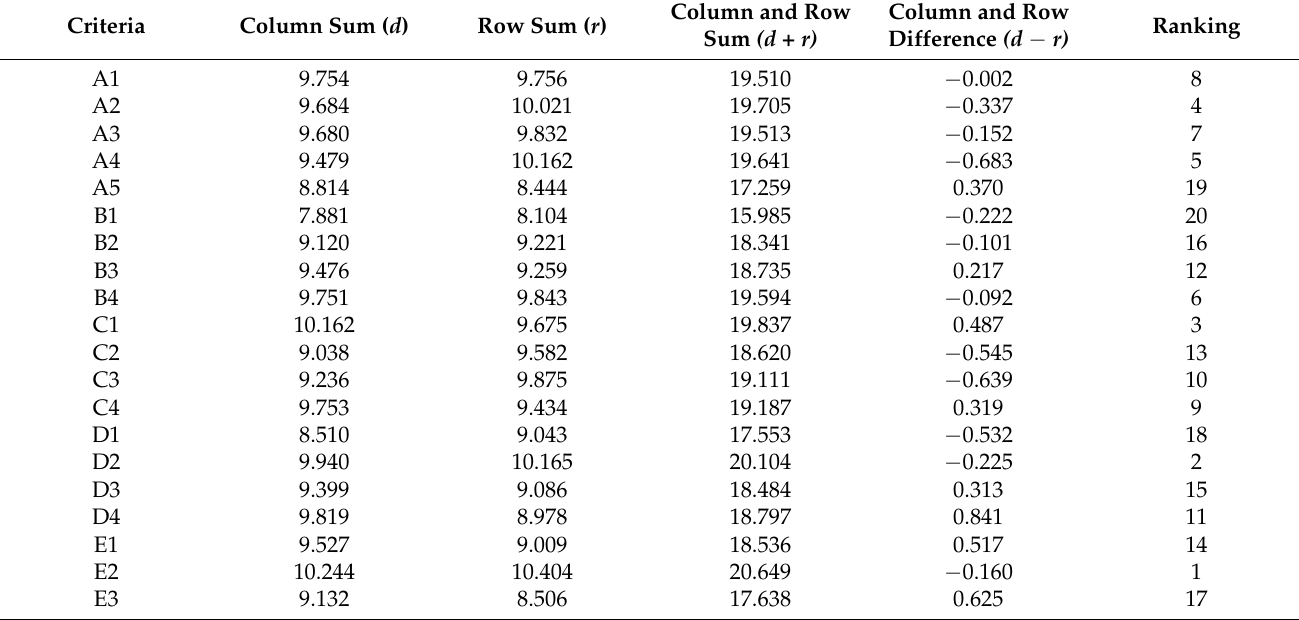
Table 2. Importance and the correlation of criteria.